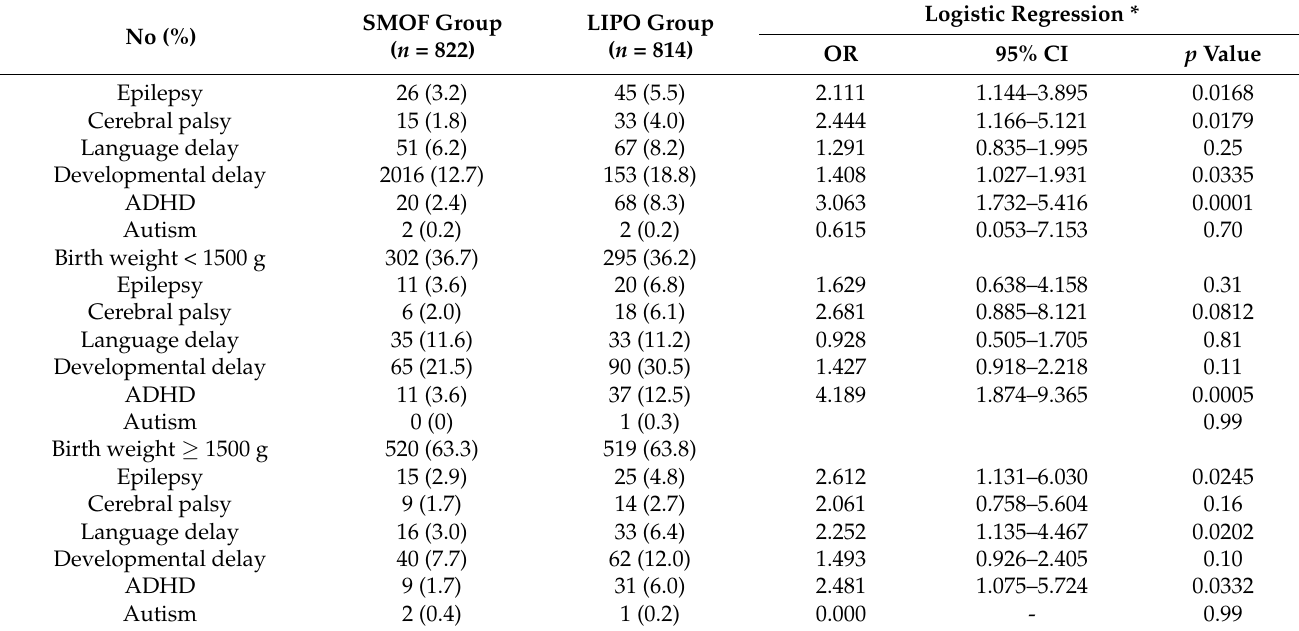
Table 3. The neurodevelopmental outcomes of SMOF and LIPO groups at two years old as corrected age ( n = 1636).